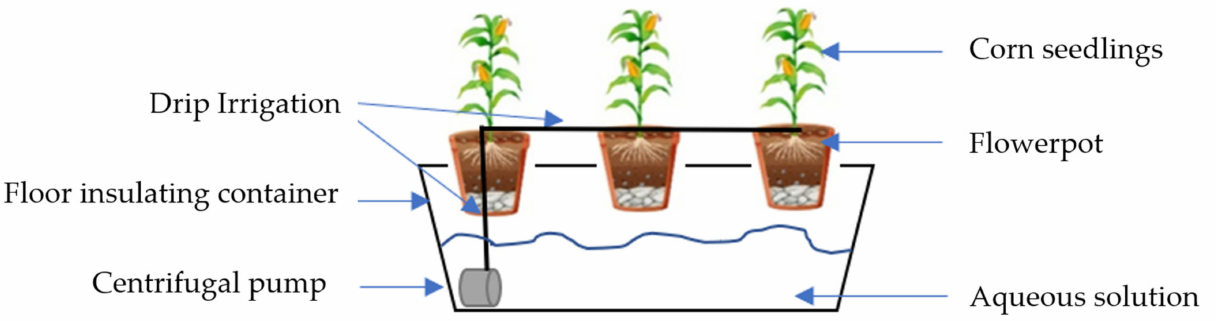
Figure 1. Diagram of double bottom irrigation unit, designed for the application of the aqueous solution of lead nitrate (Pb(NO 3 ) 2 ) for maize plants to avoid contaminating the soil of the area designated by the